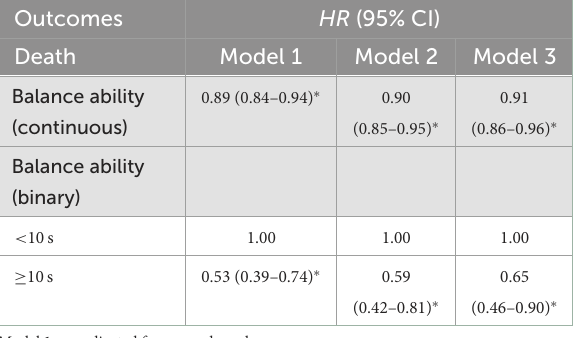
TABLE 5 Sensitivity analysis of the relationship between balance ability and death (original